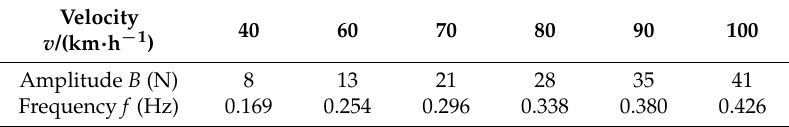
Table 3. Amplitude–frequency characteristic of the dynamic contact